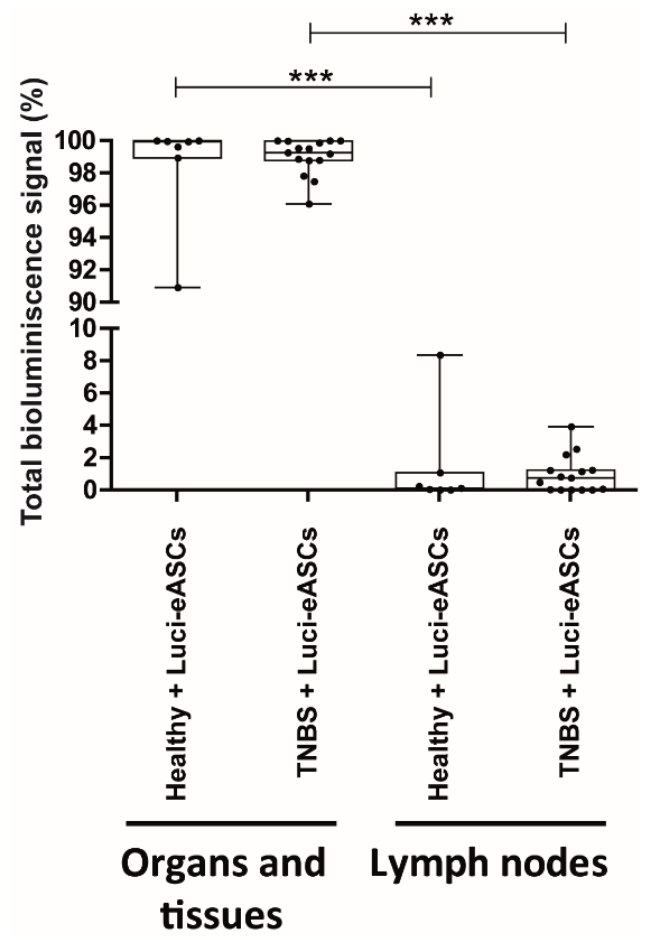
Figure 1. Analysis of total bioluminescence signal in tissues, organs and lymph nodes at 48 h following IP administration of Luci-eASCs in healthy ( n = 11) and TNBS-colitic mice ( n = 26). Bioluminescence signals measured at 48 h as percentage of light units in tissues and organs (liver, spleen, intestine, lungs, heart and blood included) and in LNs (inguinal, popliteal, parathymic, parathyroid, mesenteric, caudal and axillary included) relative to the total number of light units per mouse were expressed. Data are presented by dots and box-plots that represent the interquartile range (p75, upper edge; p25, lower edge; p50, midline; p95, line above the box; and p5, line below the box) of the percentage of total bioluminescence signal. Significance was analyzed by the Mann–Whitney U test and represented by *** p < 0.001. Results correspond to four independent experiments.